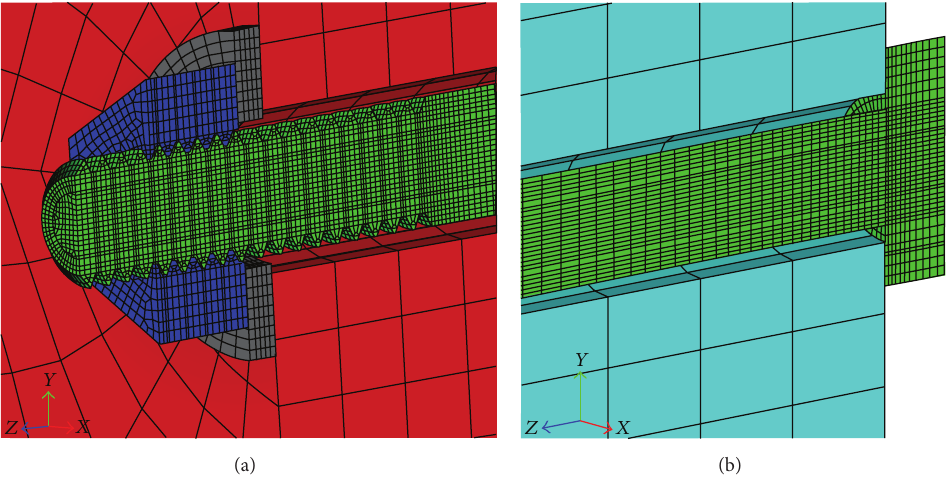
Figure 5: Section views of static tension finite element model, (a) detail of threaded end, and (b) detail at head.